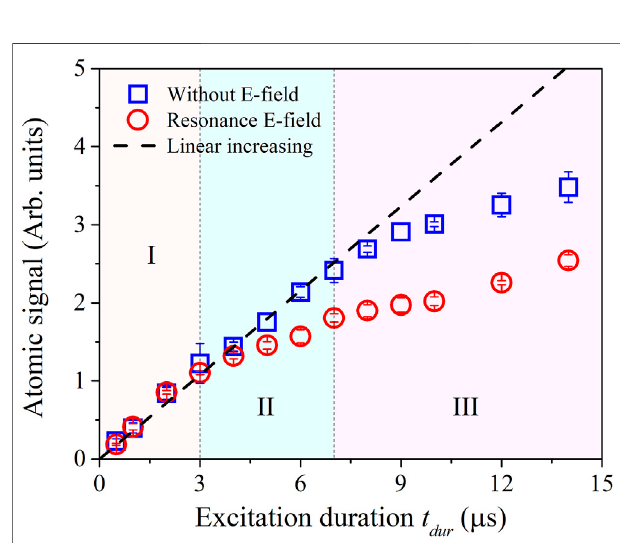
FIGURE 5 | (color online). Measured fi eld ionization signal of |40P 3/2 〉 Rydberg state as a function of the excitation duration with (red circles) and without (blue squares) the DC electric fi eld. The black dashed line displays the